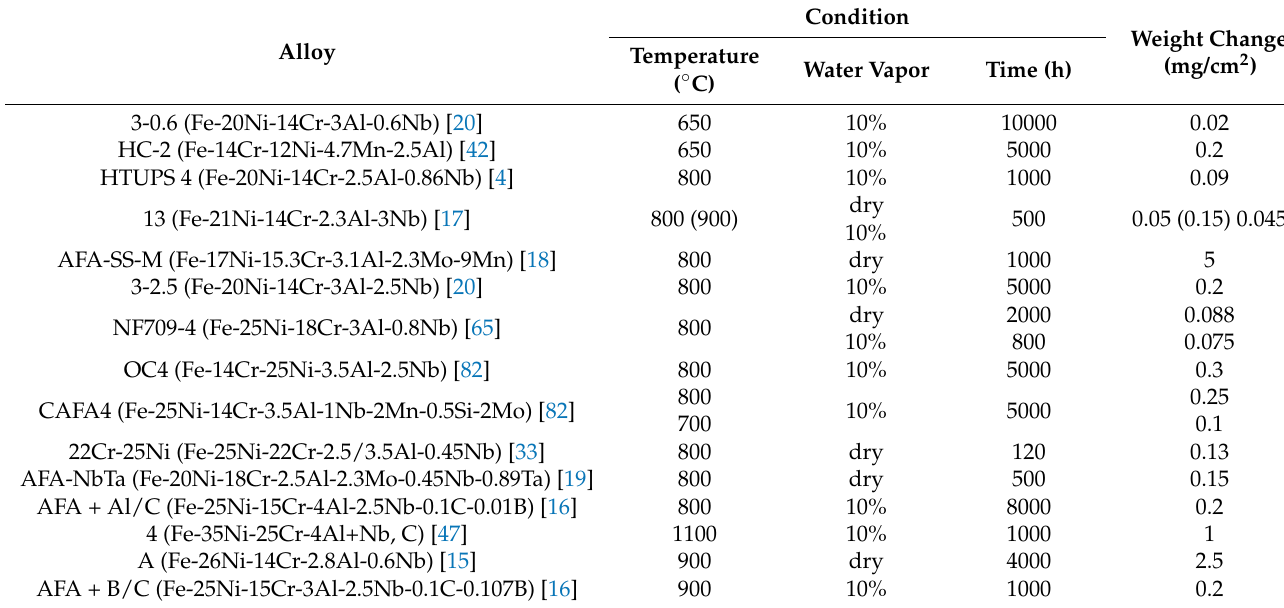
Table 3. Oxidation resistance of AFA steels in